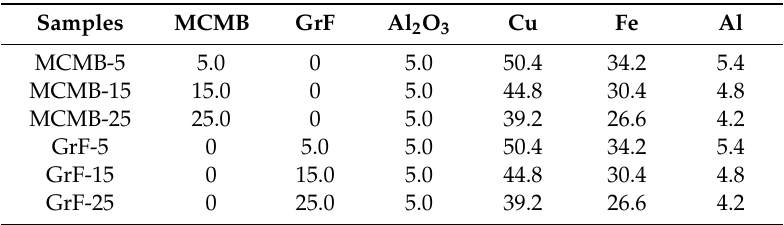
Table 1. Chemical compositions (vol.%) of the mesocarbon microbead (MCMB)–Cu composites and graphite flake (GrF)–Cu